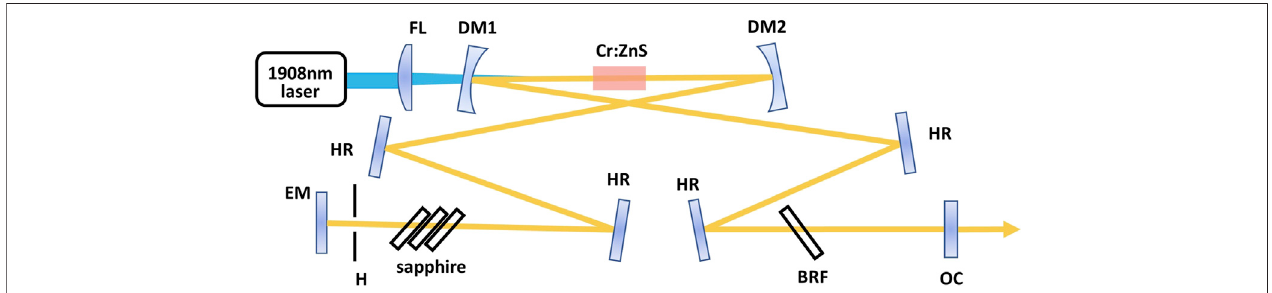
FIGURE 1 | Kerr-lens mode-locked Cr:ZnS oscillator. FL, focusing lens ( f = 100 mm); DM, curved dichroic mirror (ROC = 100 mm); EM, end mirror (the same as HR, high re fl ection, at 2,150 – 2,700 nm); OC, output coupler, T = 10% at 1,700 – 2,700 nm; H, hard aperture; BRF, birefringent fi lter.